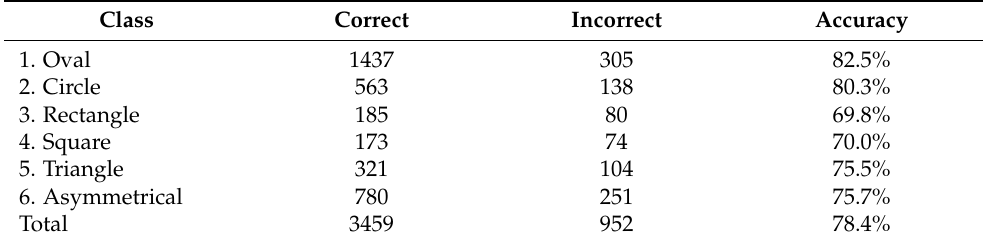
Table 1. Classification by form using the shape parametric description (SPD) approach.